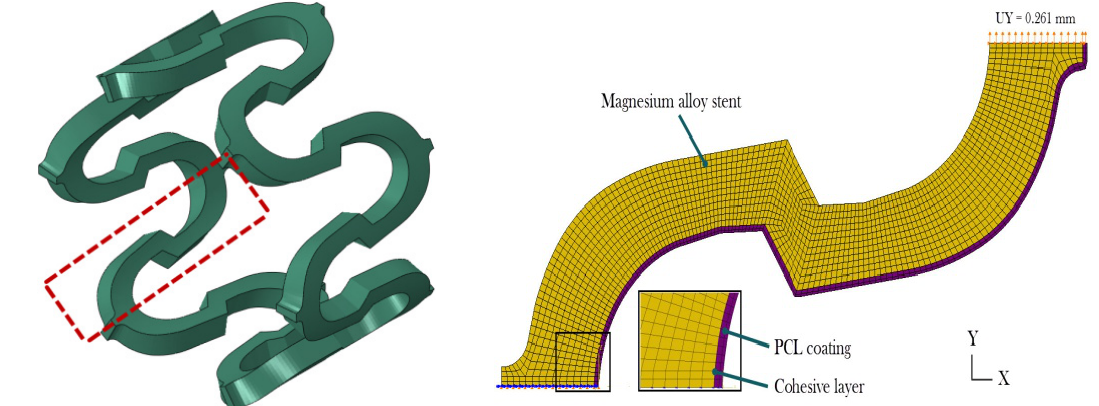
Figure 10: 3D one ring model of OPT (left) and 2D coated OPT stent strut model.